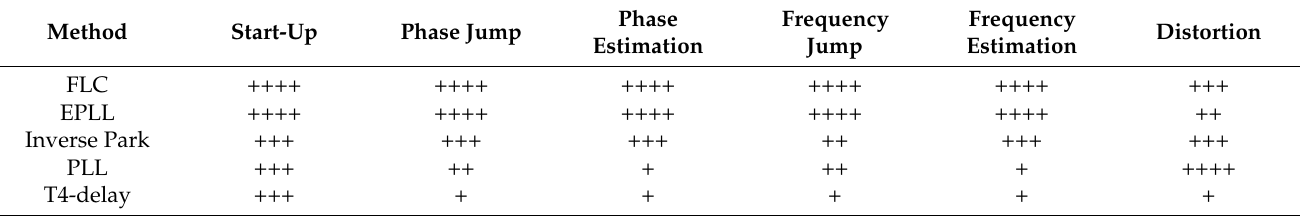
Table 2. Comparison